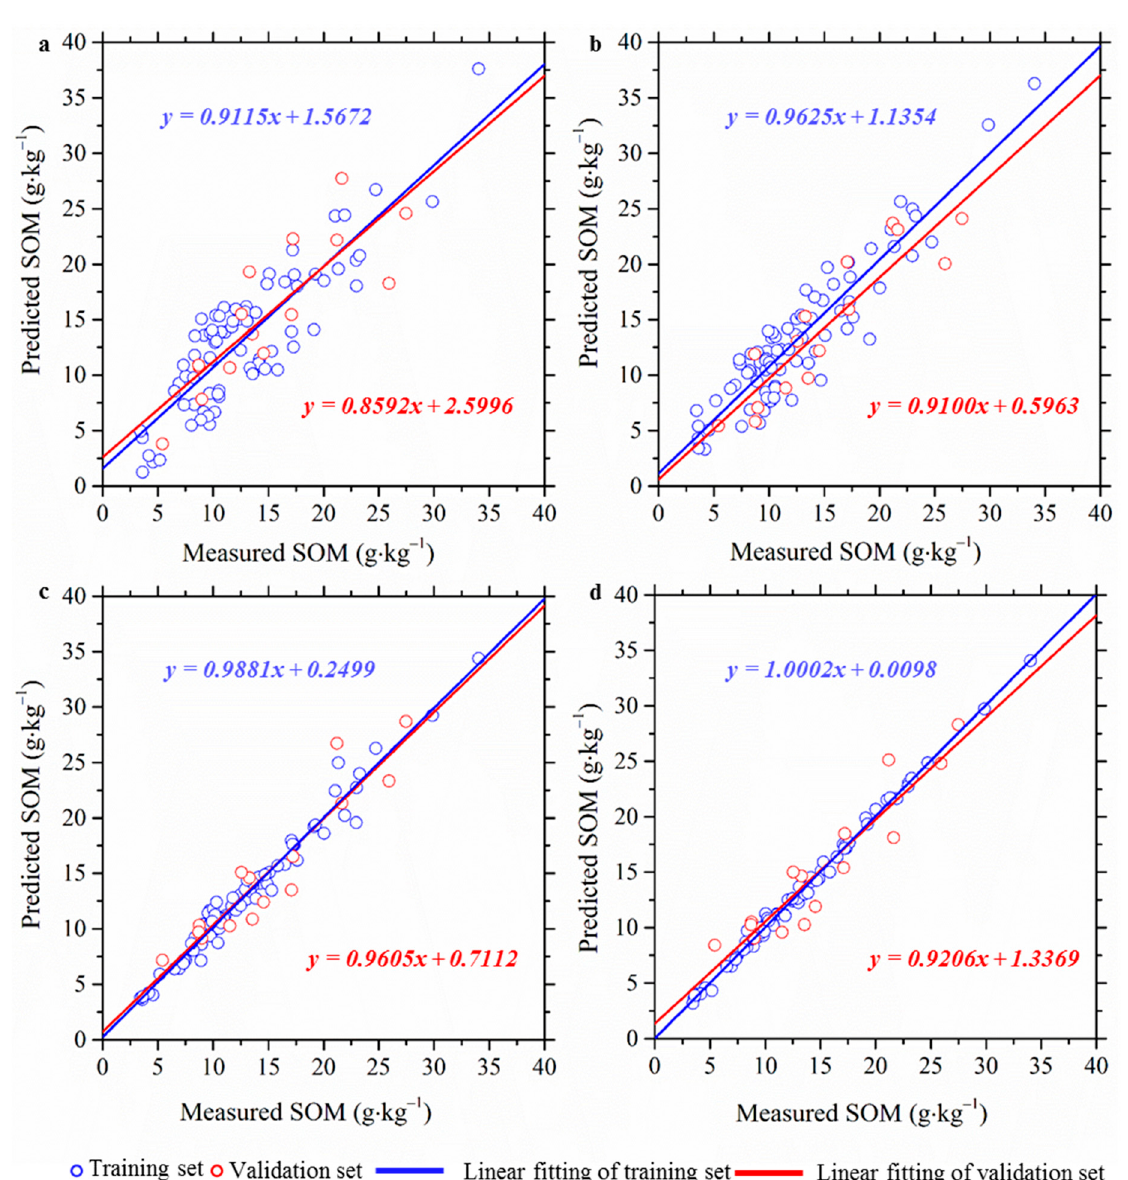
Figure 4. Scatter plots and corresponding fitting curves of measured SOM and predicted SOM for ( a ) RR, ( b ) LS-SVM, ( c ) RF, and ( d ) GBRT. The training set and validation set were derived from one of the 20 cross-validation